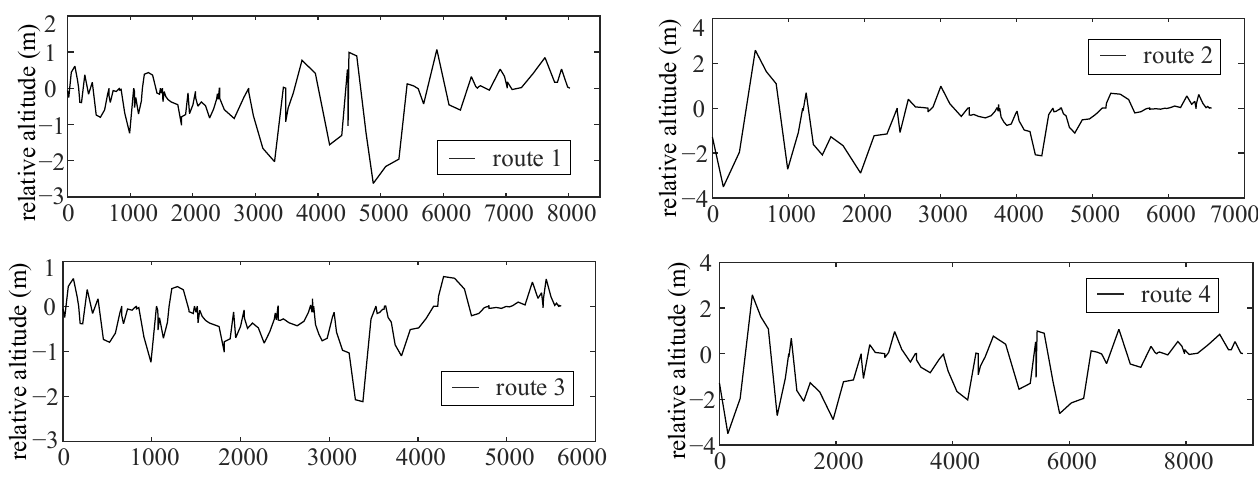
Figure 8. Relative altitude of the selected route. At each intersection, once the vehicle speed and prediction time are determined, the relative altitude and slope within the predicted range are regarded as samples to construct the state transition probability matrix for slope prediction. The specific process is shown in Figure 9.